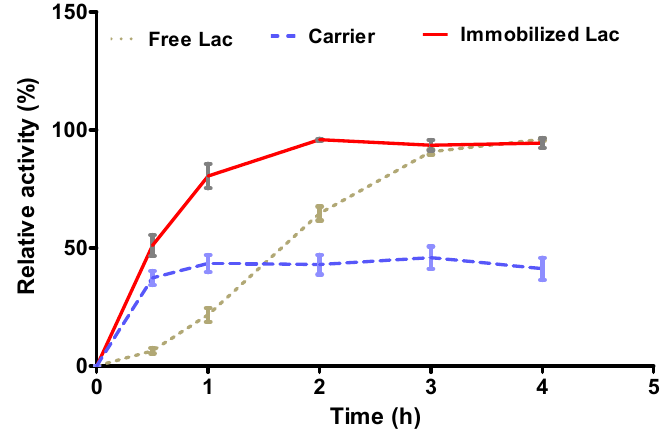
Figure 7. Removal of dye by free Lac, immobilized Lac, and carrier versus time.